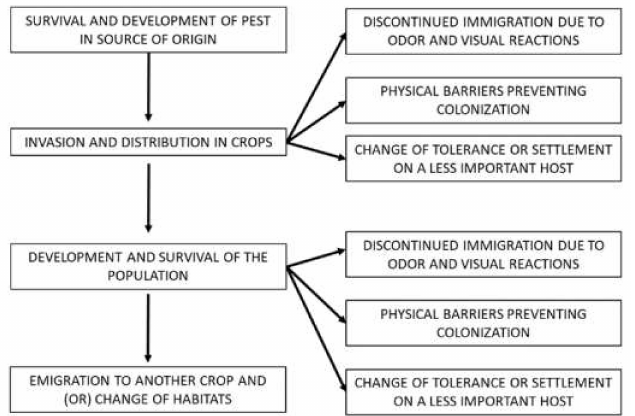
Figure 1. Stages in the dynamics of pest populations resulting from mixed cultivation. Possible effects are listed on the right